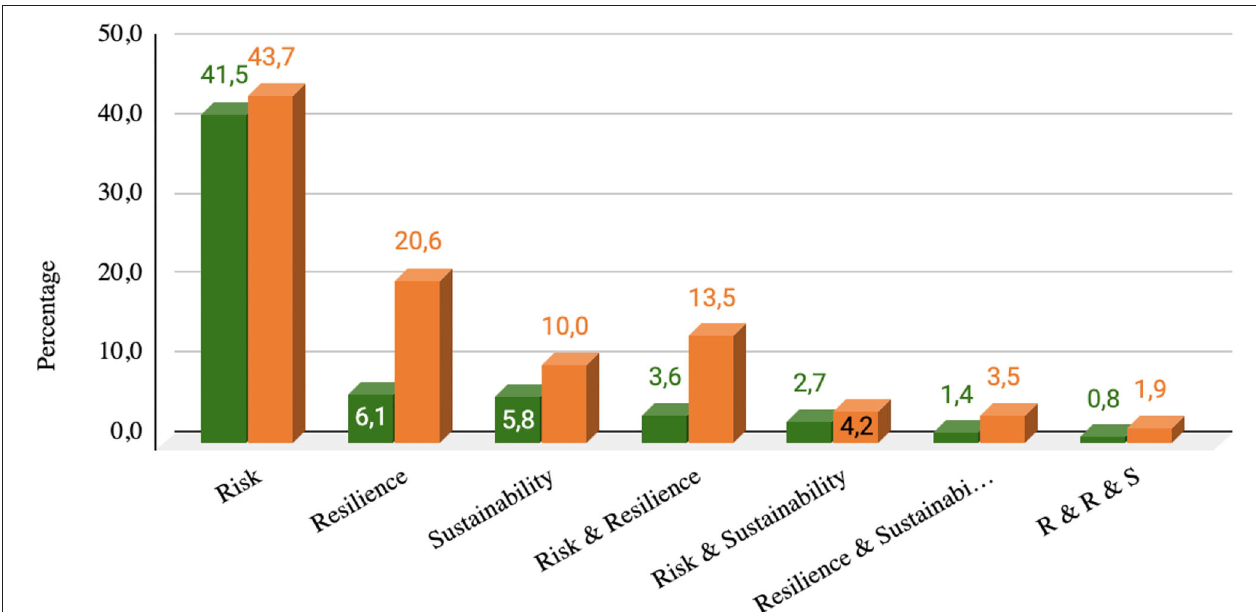
FIGURE 10 | Risk, resilience, and sustainability (RRS) contribution per dataset (green, GN; orange,